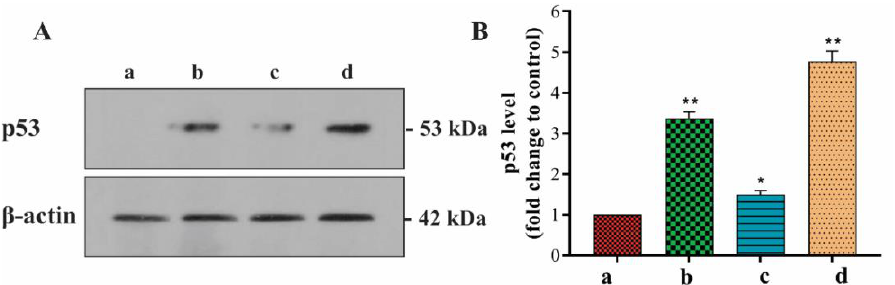
Figure 9. ( A ) Descriptive images of western blot analysis of p53 expression relative to β -actin as an internal control. ( B ) p53 protein level (fold change to control) in A549 cells treated with IC 50 concentration of P. eldarica extracts and essential oil for 48 h. a. Control group, b. pollen hexane extract-treated group (31.7 µg/mL), c. bark essential oil-treated group (17.9 µg/mL), and d. methanolic needle extract-treated group (0.3 µg/mL). Data are expressed as mean ± standard deviation (SD), representative of three independent experiments. * p < 0.05 and ** p < 0.01 vs. control.